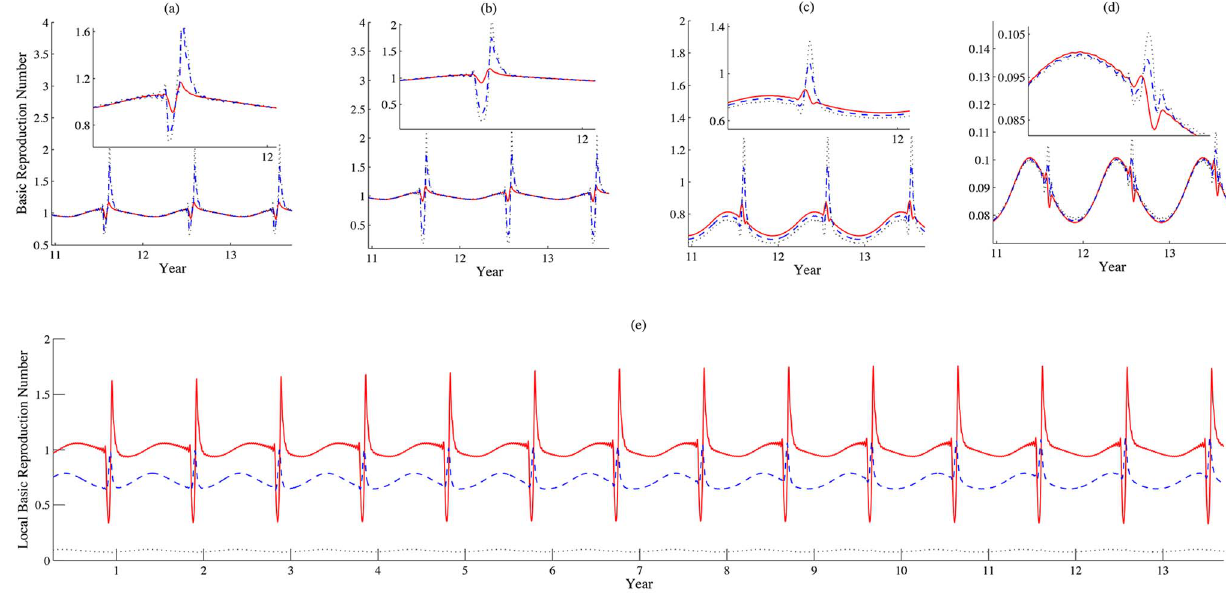
Fig. 8. How daily increment in movement speed impacts basic reproduction numbers. (a) Instantaneously global reproduction number; (b)-(d) Instantaneously local reproduction numbers in patches 1, 2 and 3. In (b)-(d), dc ~ 10, 54, 98 km per day, described by solid, dashed and dotted lines, respectively. (e) Local reproduction number in patches 1, 2 and 3 are simulated by solid, dashed and dotted lines when dc ~ 54 km per day. Values of other parameters are identical with those used in Fig. 3.